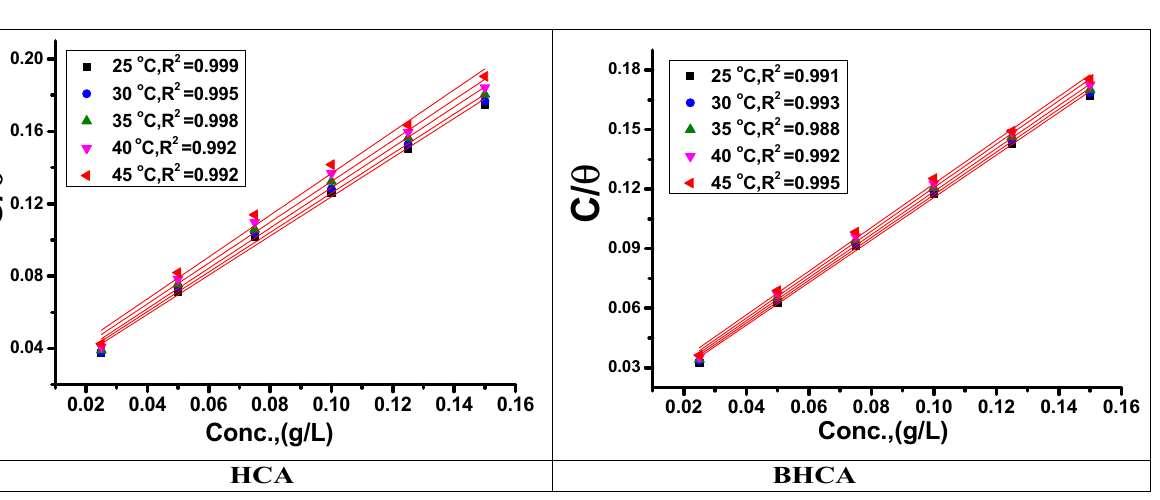
Figure 4. “Langmuir isotherm plots as C/θ vs. C, of HCA & BHCA for dissolution of CS in 1 M HCl at various